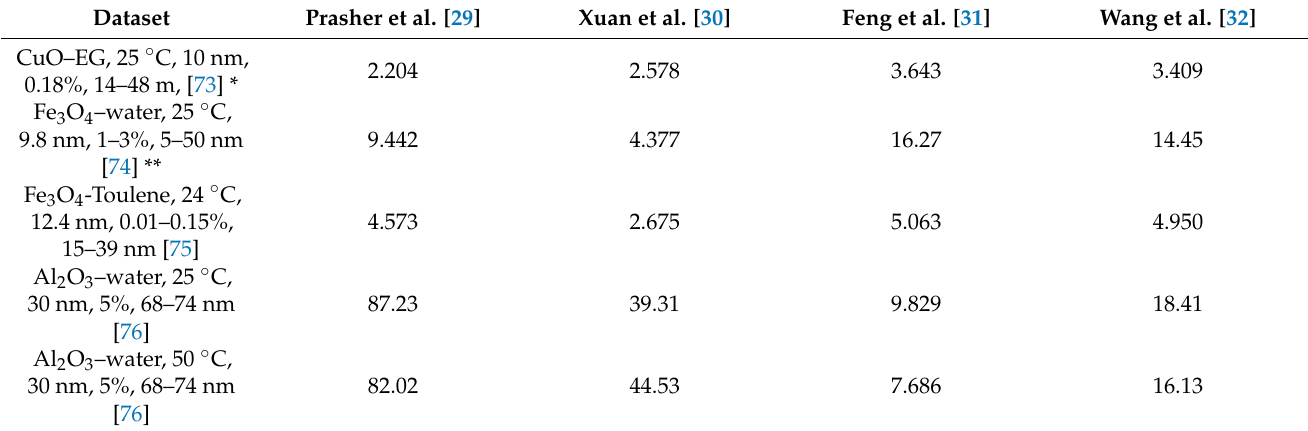
* Experimental data used in Figure 8; ** Experimental data used in Figure